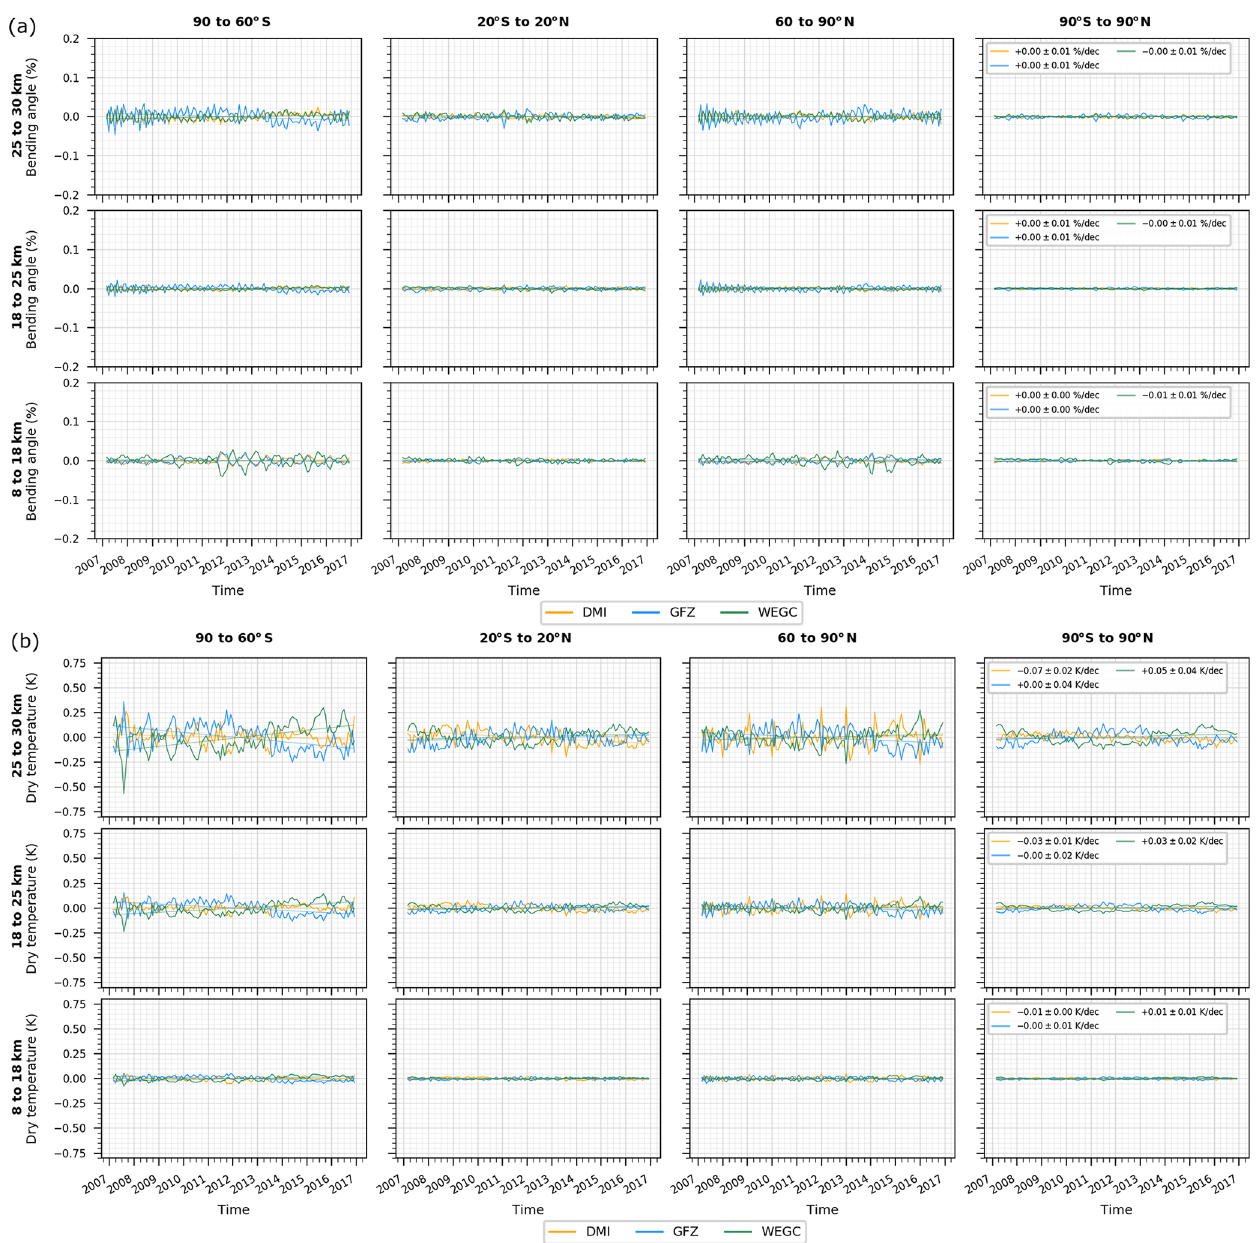
Figure 6. GRACE bending angle (a) and dry temperature (b) de-seasonalized anomaly difference time series based on 10 ◦ zonal medians of each center to the all-center mean for latitude bands 90 to 60 ◦ S, 20 ◦ S to 20 ◦ N, 60 to 90 ◦ N, and globally 90 ◦ S to 90 ◦ N (left to right) for altitude layers 8–18, 18–25, and 25–30km (bottom to top). Time series from DMI (orange), GFZ (blue), and WEGC (green) are shown.